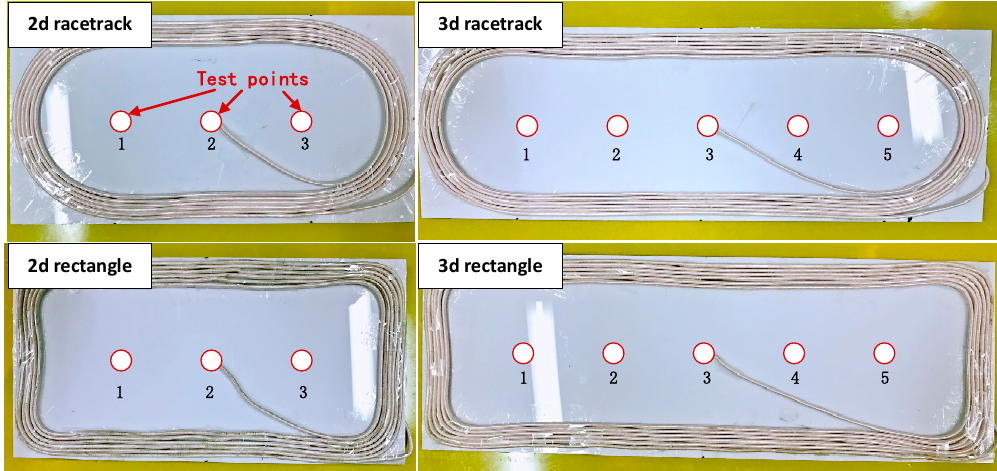
Figure 9. Transmitting track with different shape and length.